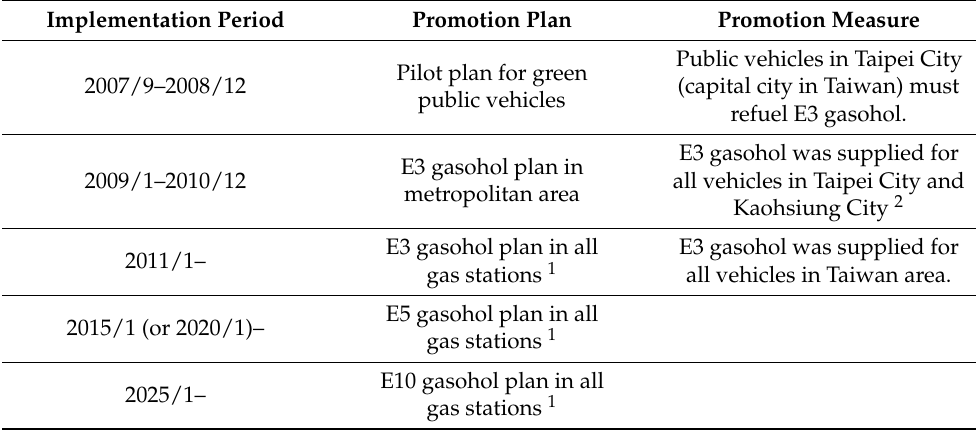
Table 6. Various stages of development plans for bioethanol in